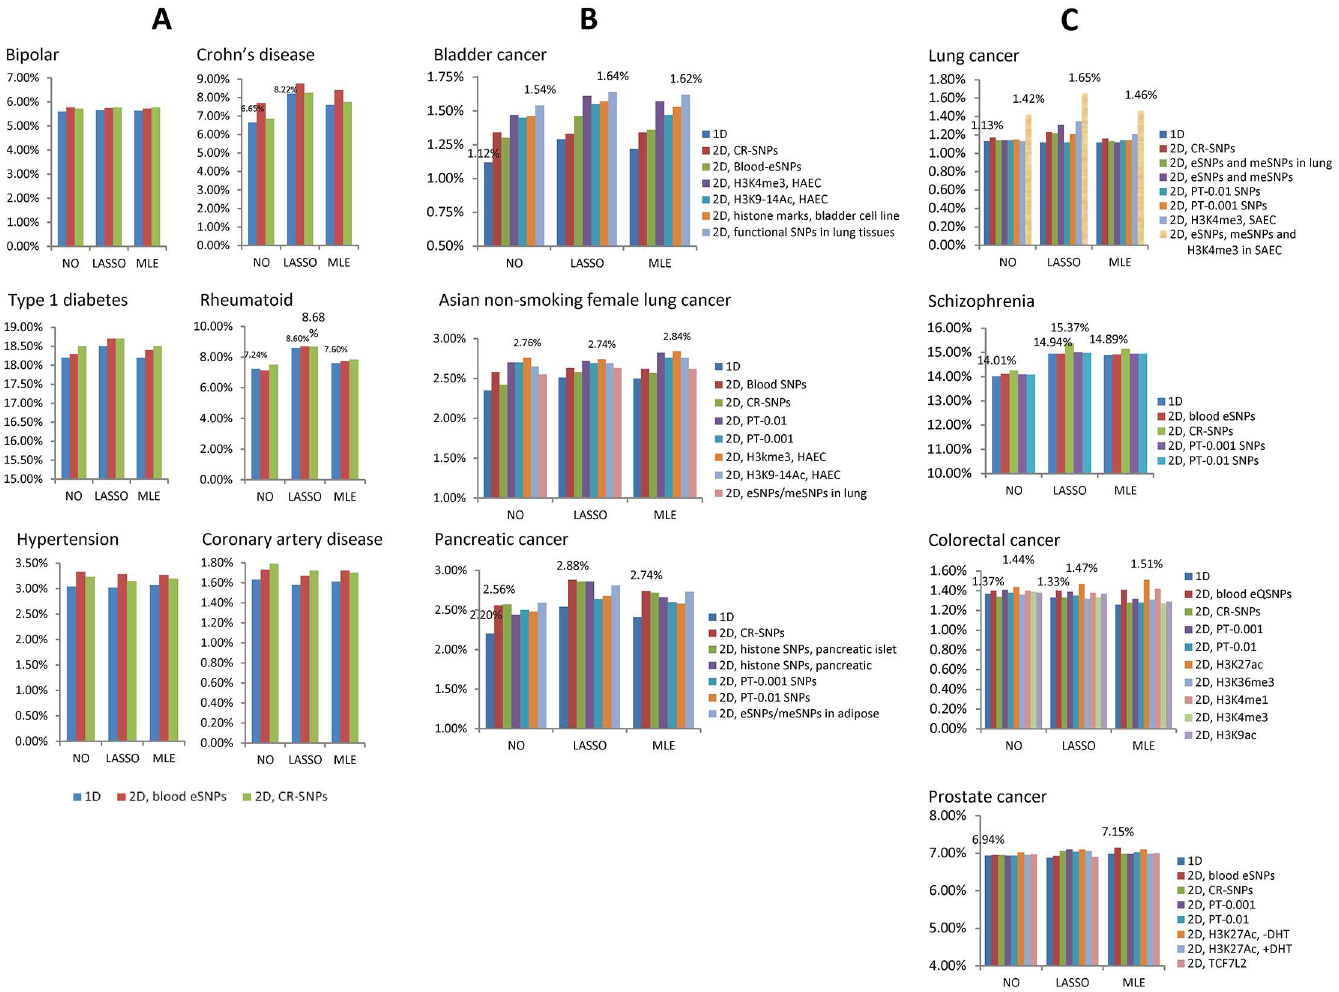
Fig 4. Comparison of polygenic risk prediction methods for 13 complex diseases. For all figures, the y-coordinate is the prediction R 2 in the observational scale. “1D” denotes1D PRS; “2D, blood eSNPs” denotes 2D PRS using blood eSNPs as high-priorSNP set. In the x-axis, “NO” denotesPRS without winner’scurse correction; “LASSO” and “MLE” denote lasso-typeand MLE winner’scurse correction, respectively.(A) PredictionR 2 values for six diseasesin WTCCC data, estimated based on five-fold cross-validation. (B) PredictionR 2 values for three GWAS of cancers, estimated basedon ten-fold cross-validation.(C) PredictionR 2 values for four complex diseasesestimated based on independent